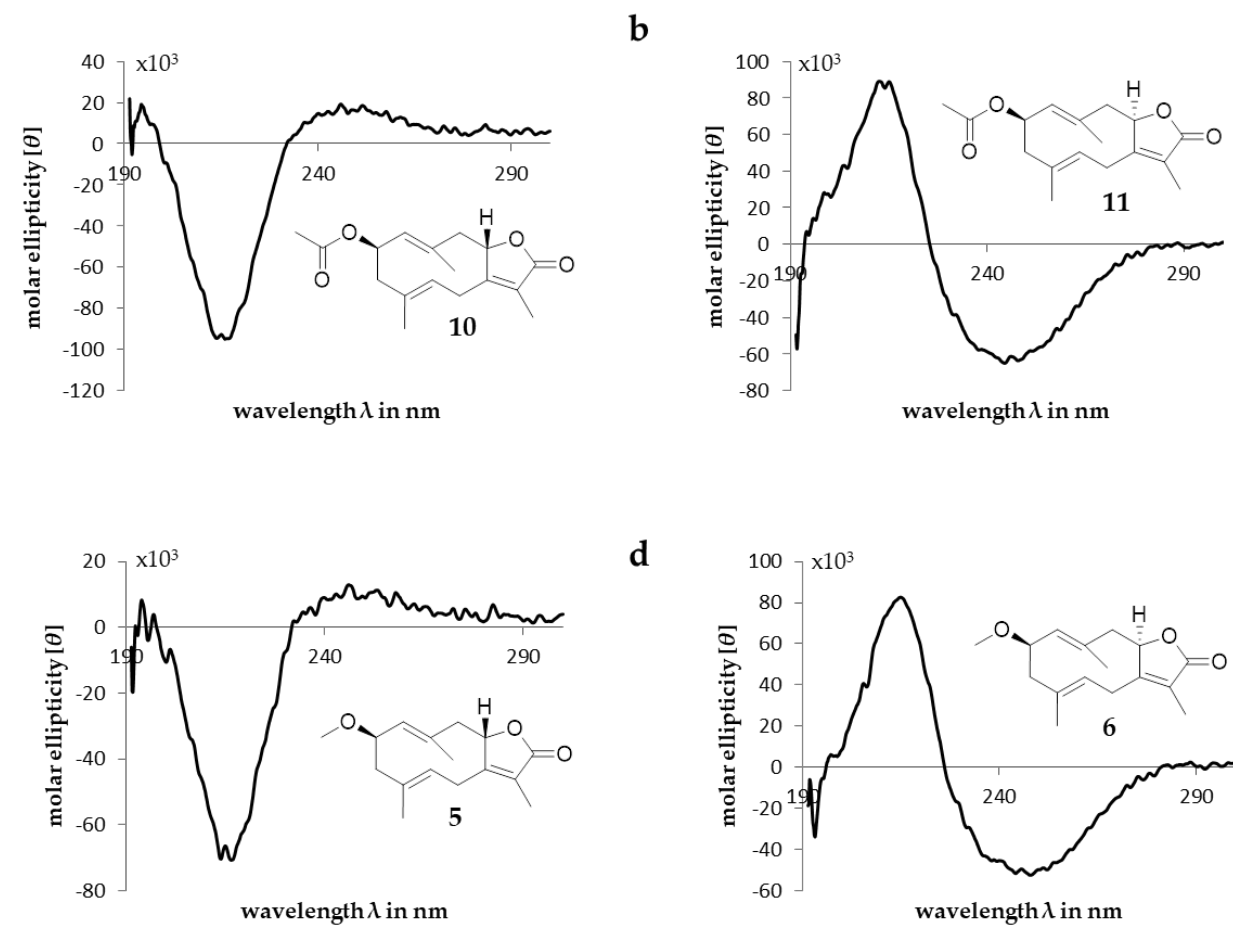
figurations: a ( rel -2 R ,8S) configuration can be postulated for 5 , whereas for compound 6 , a ( rel- 2 R ,8 R ) configuration can be assumed. In analogy to 10 and 11 , the semitrivial names